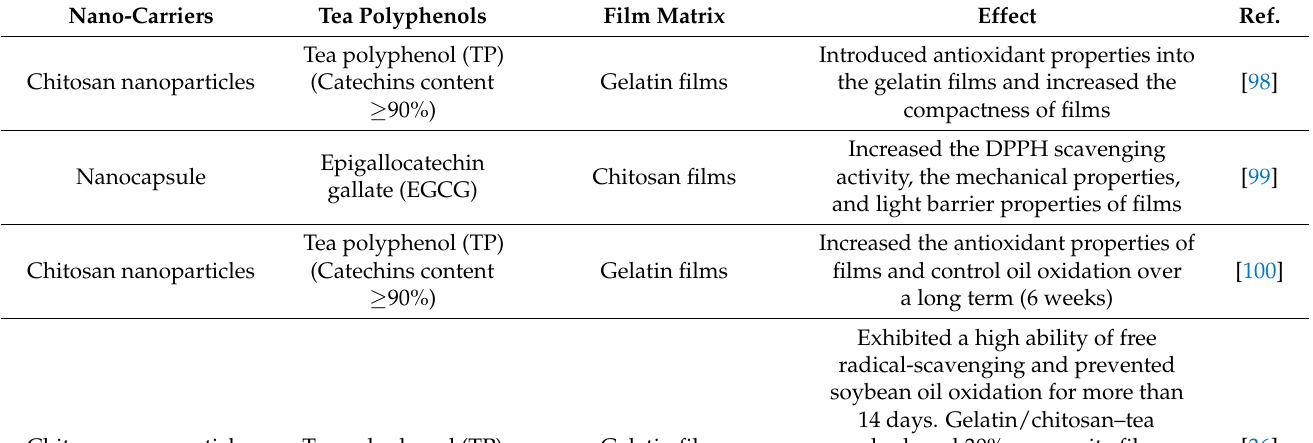
Table 3. Applications of TPs nanostrategies in active food